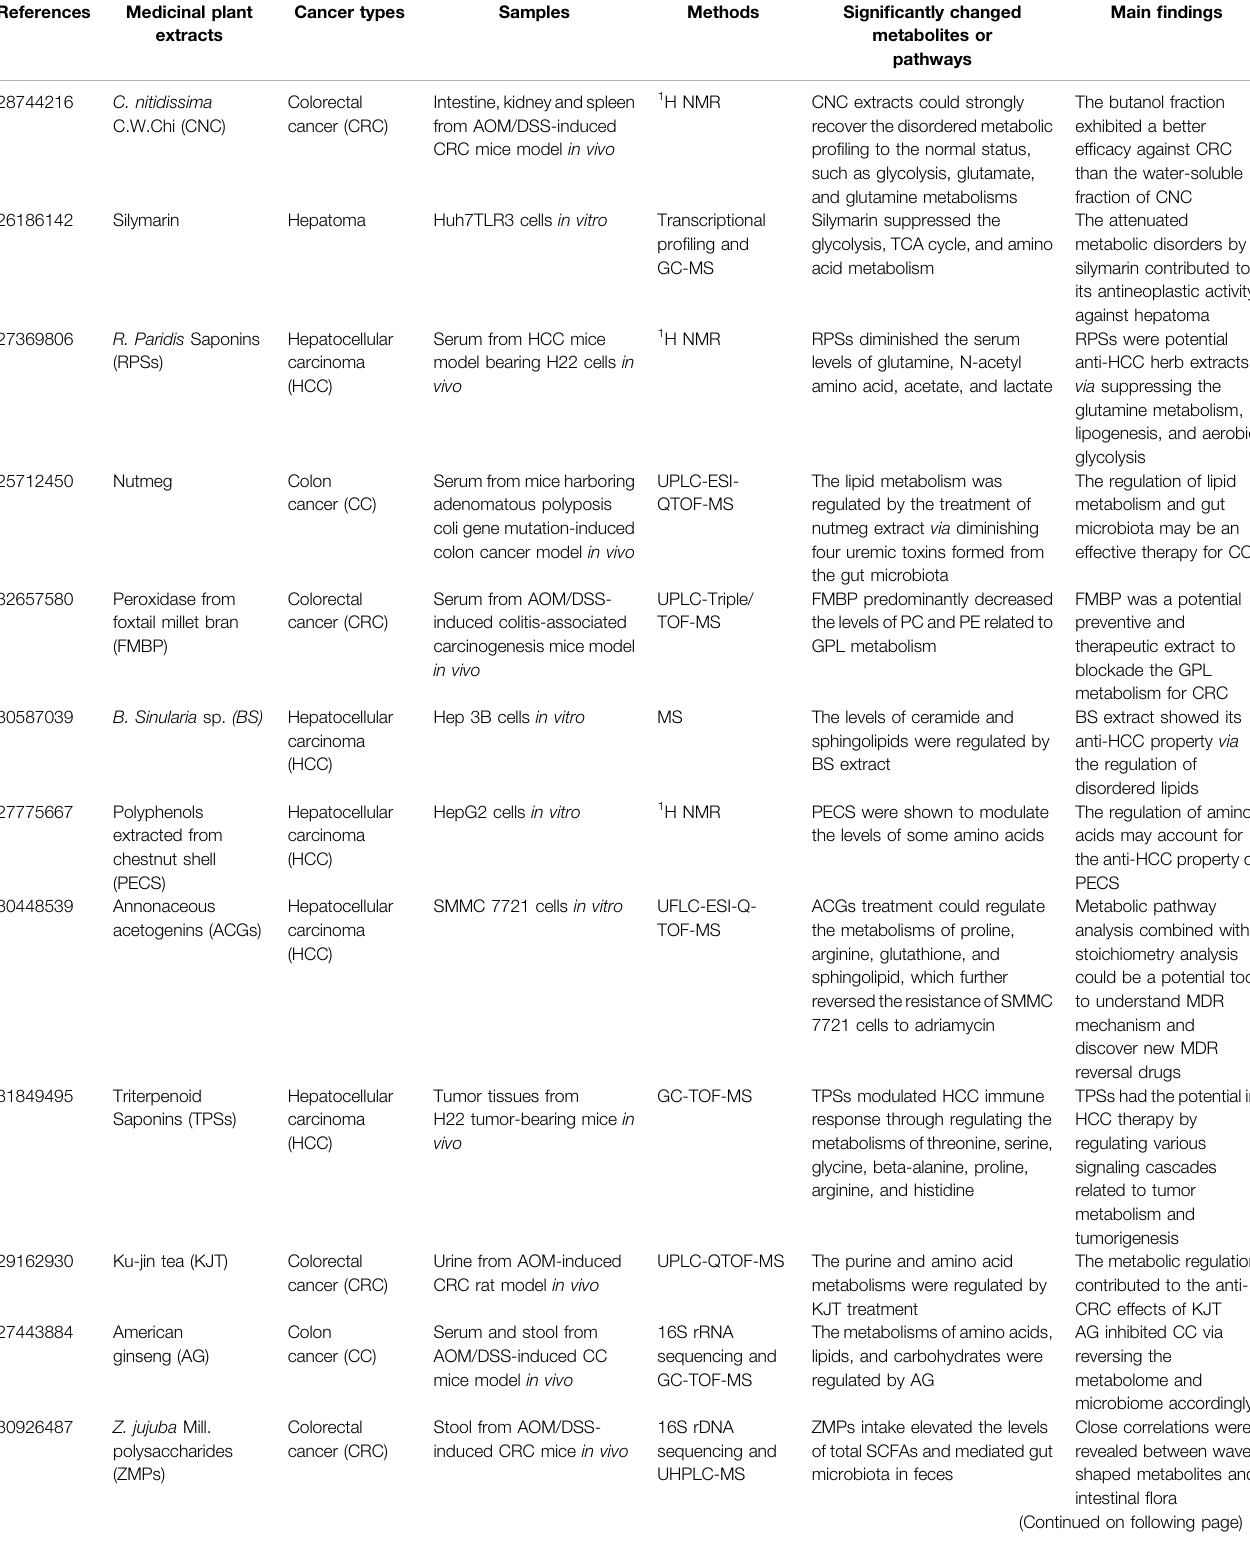
TABLE 2 | The summary of recent metabolomics investigations on anti-GIC therapies of extracts from medicinal